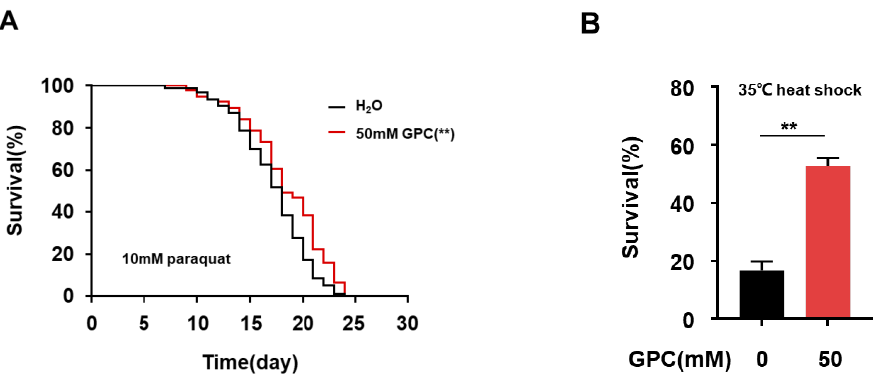
Figure 5. GPC enhances stress resistance in C. elegans . ( A ) Representative survival curves of worms under oxidative stress. The nematodes on day 6 of adulthood treated with or without 50 mM GPC were transferred to the NGM plate with 10 mM paraquat. p values represent comparison with vehicle calculated using long rank test. ( B ) Survival for day 2 nematodes treated with or without 50 mM GPC was recorded after being exposed to 35 ◦ C heat shock for 7 h. ** p ≤ 0.01 by unpaired t test. Values are mean ±